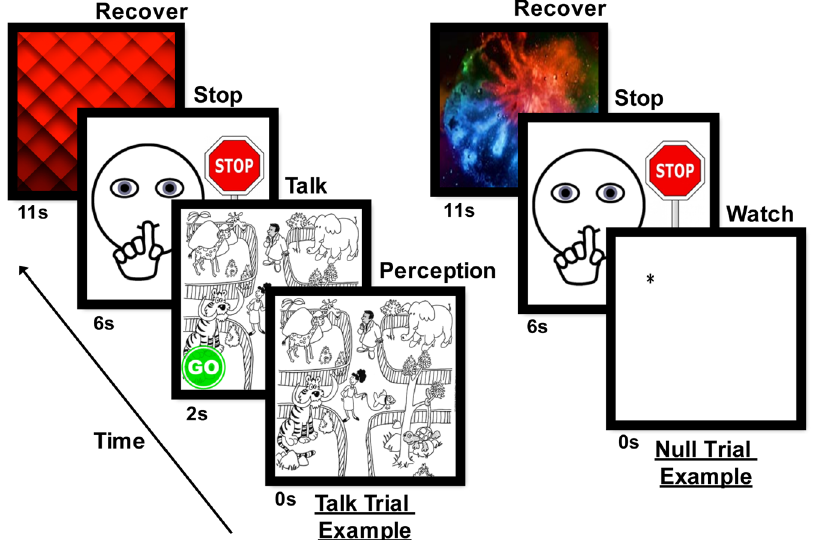
Figure 4. Experiment overview. Example of a talk trial (left slides) and a null trial (right slides). For the 30 talk trials, children viewed each picture for 2 s. A green “go” circle appeared in the corner of the picture cueing the children to begin speaking. After 4 s of speech, a stop sign appeared cueing the children to stop speaking. Finally, a patterned slide, devoid of overt semantic content, remained on the screen for 10–12 s to allow the hemodynamic response to recover. For the 15 null trials, the children watched a fixation point for 6 s (the amount of time they would have seen and described a picture) followed by the a stop sign and patterned recovery slide. The talk and null trials were randomized for presentation. Zoo illustration used with permission from Super Duper ®